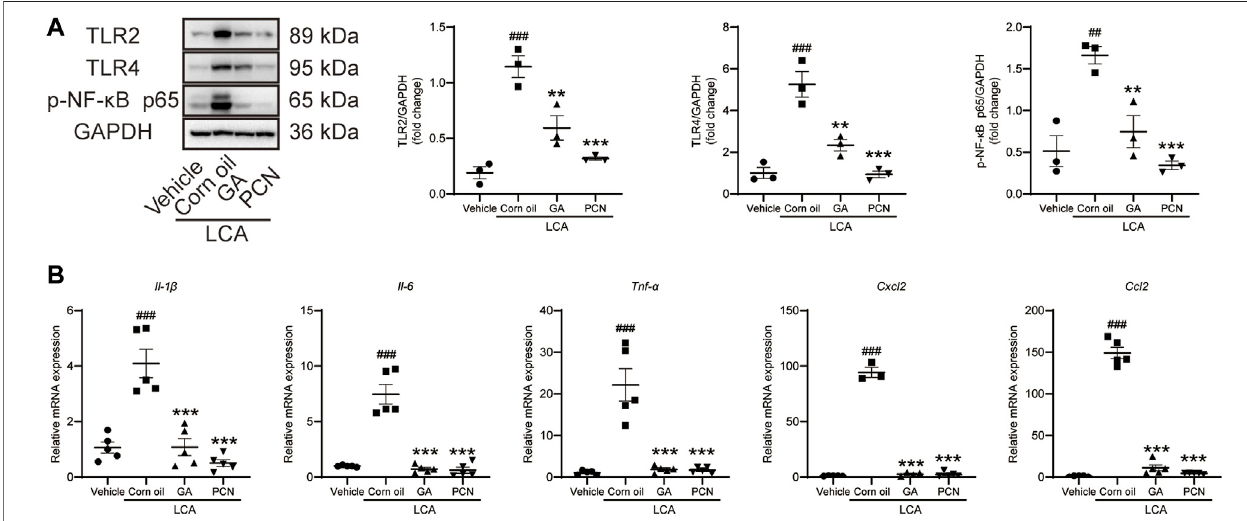
FIGURE 4 | GA suppressed hepatic TLR S /NF- κ B signal pathway in mice induced by LCA. (A) Proteins of liver extracts were evaluated by Western blotting for the determinationofTLR2,TLR4,andp-NF- κ B-p65levels. (B) mRNAlevelsof Il-1 β , Il-6 , Tnf- α , Ccl2 ,and Cxcl2 inthehepatictissuesweremeasuredbyRT-qPCR.Dataare shown as mean ± SD ( n = 5). ## p < 0.01 and ## p < 0.001 vs. vehicle group; ** p < 0.01 and *** p < 0.001 vs. LCA group.